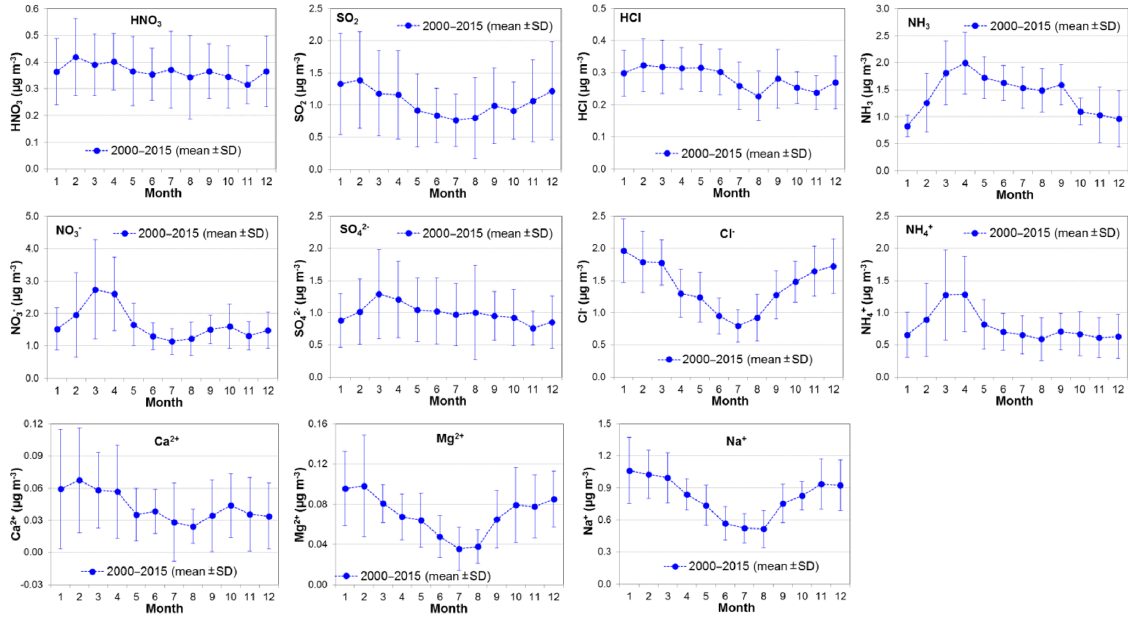
Figure 8. Average annual cycles for HNO 3 , SO 2 , HCl and aerosol NO − and Aerosol Monitoring Network (AGANet). The NH 3 and NH + Monitoring Network (NAMN, Tang et al., 2018) are also shown for comparison. Each data point in the graphs represents the mean ± SD of monthly measurements of all sites in the network.